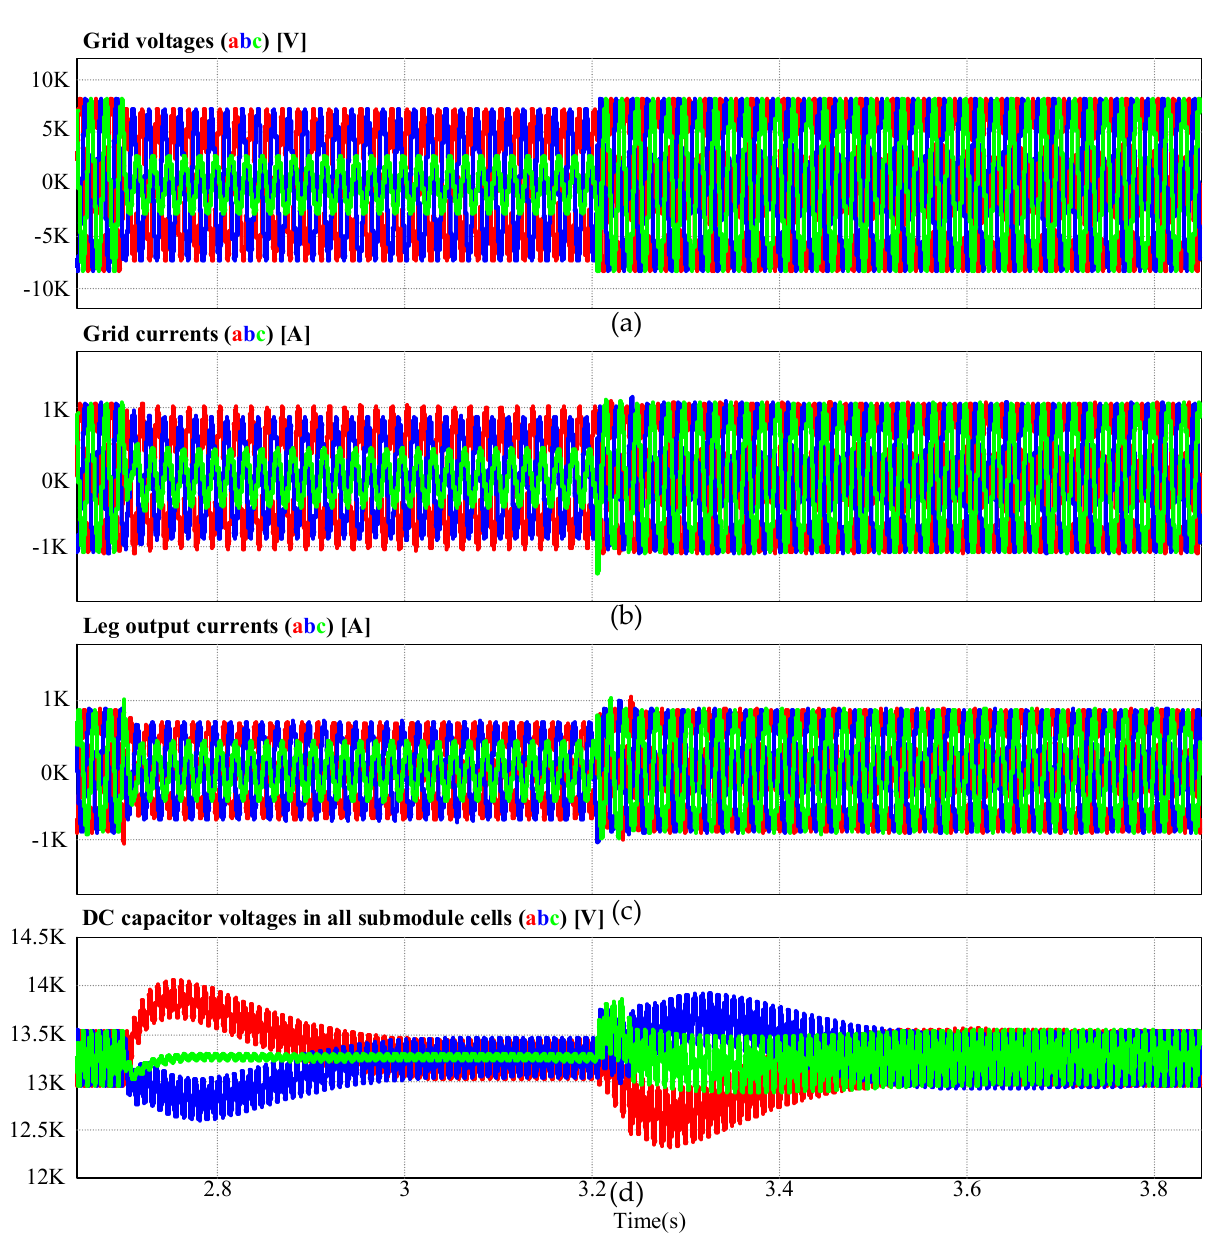
Figure 7. Simulation results under unbalanced grid conditions when the feedforward is not applied: ( a ) three-phase grid voltages; ( b ) three-phase grid currents; ( c ) three-phase leg output currents; ( d ) DC capacitor voltages in all submodule cells. As shown by the simulation results, the proposed feedforward method is effective and reliable under both unbalanced grid and load conditions. When the proposed feedforward term is applied, the peak values of DC capacitor voltages can be reduced, and the dynamics of the leg energy balancing controller can be improved. Therefore, the stability of the CHB–STATCOM system can be